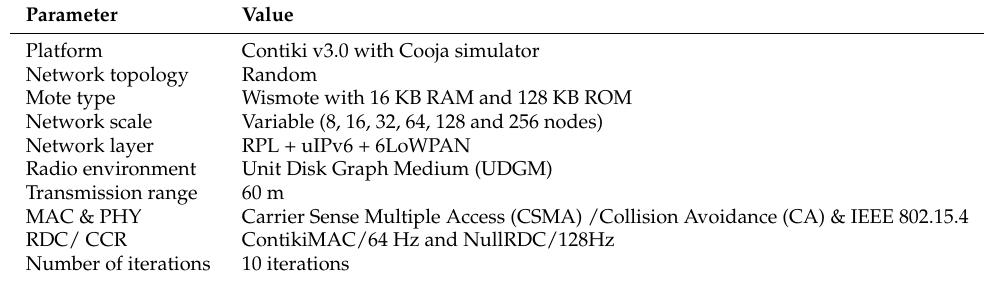
Table 1. Simulation